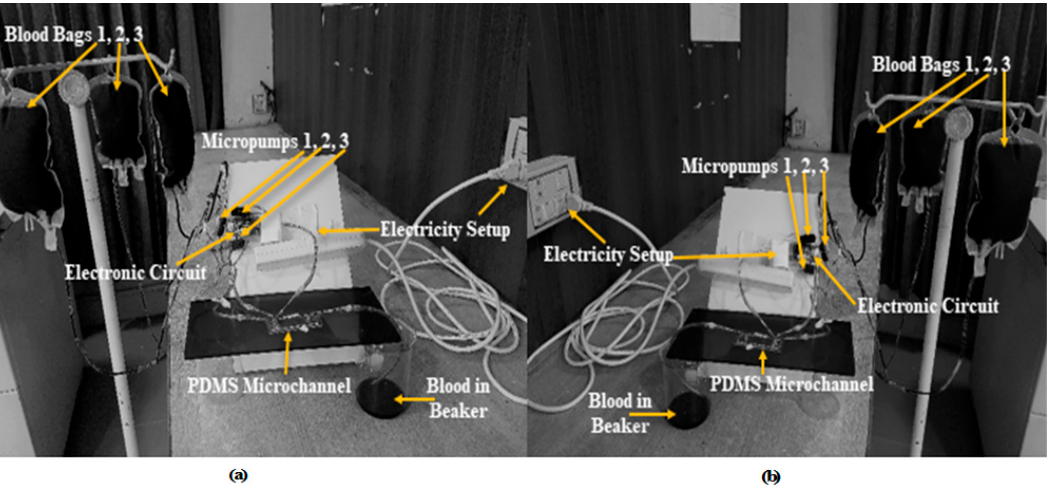
Figure 15. Experimental setup ( a ) 5CACMC ( b ) 5CDCMC.